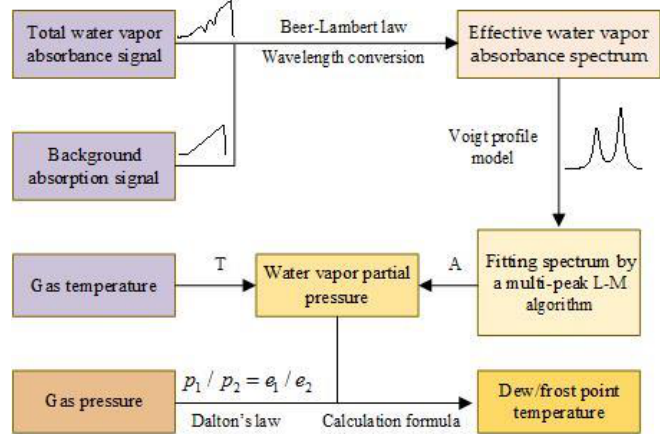
Figure 4. A diagram of the data processing